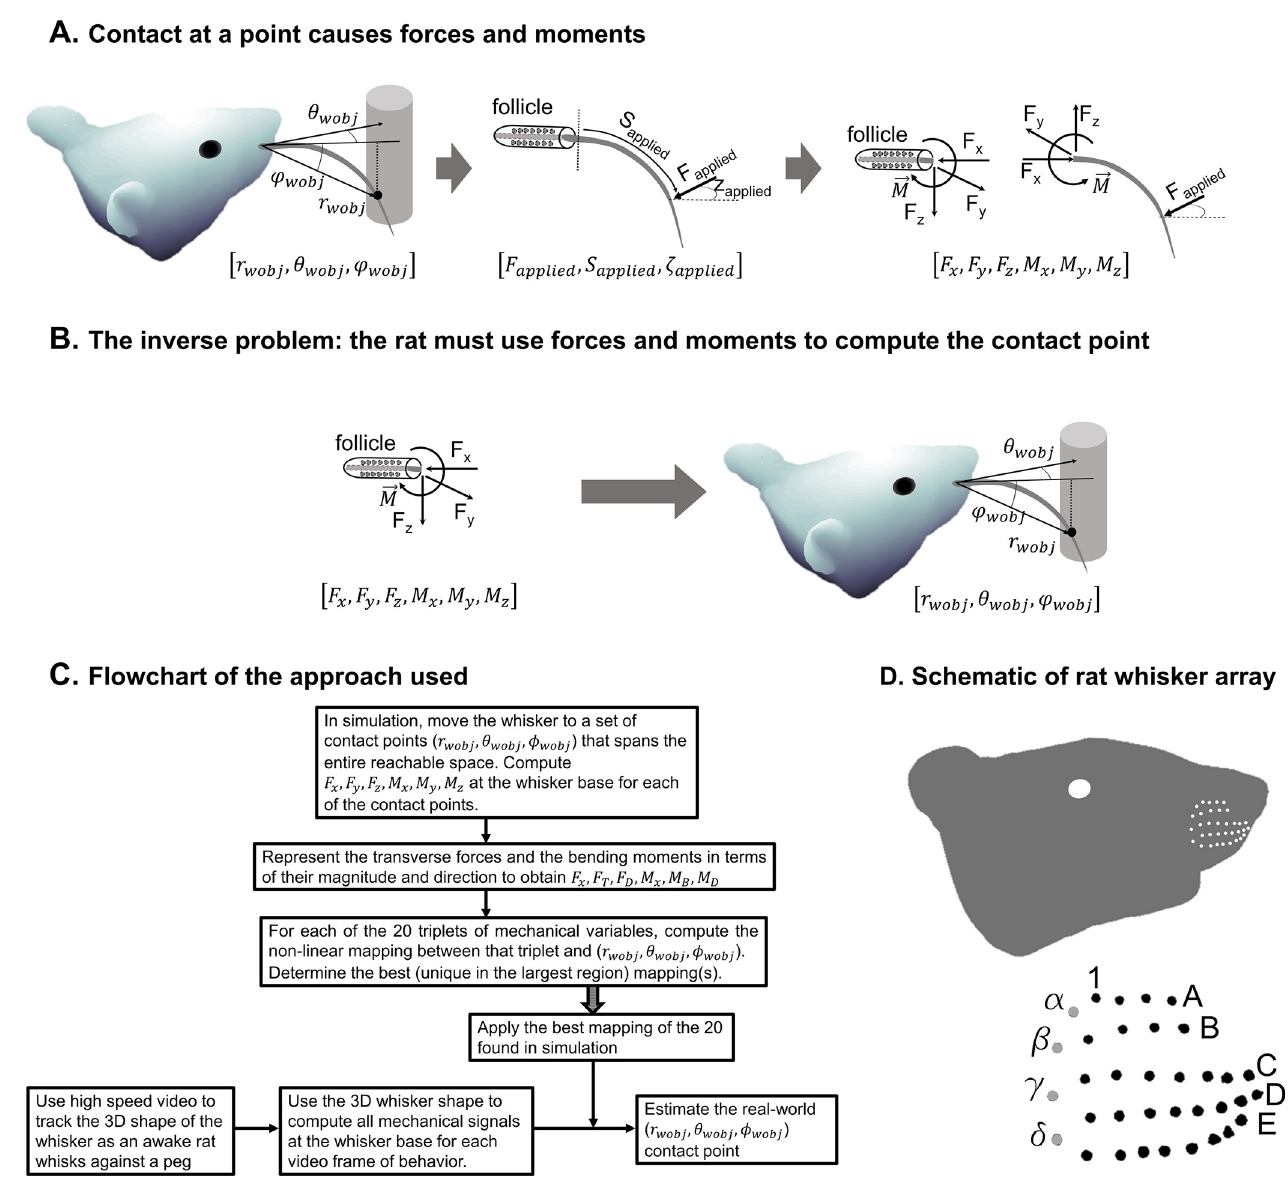
Fig 1. When a rat whisks against an object, forces and moments are generated at the whisker base; the rat must use these forces and moments to determine the 3D contact point location. (A) The 3D contact point between the whisker and the object is denoted as r wobj , θ wobj , and φ wobj . This contact point exerts a force on the whisker (F applied ), which generates reaction forces and moments at the whisker base. (B) The inverse problem: the rat’s nervous system must perform the inverse of the process depicted in (A). (C) A flowchart that describes the approach taken to determine the non-linear mappings that could allow the rat to solve this inverse problem. The 20 mappings indicated in the center box are listed in Fig A in S1 Text. (D) A schematic of a rat head and approximate locations of the whisker basepoints. Whiskers in the caudal-most column (denoted as gray dots in the expanded view) are identified with the Greek letters α through δ . Columns are numbered from caudal to rostral, and rows are lettered from dorsal to